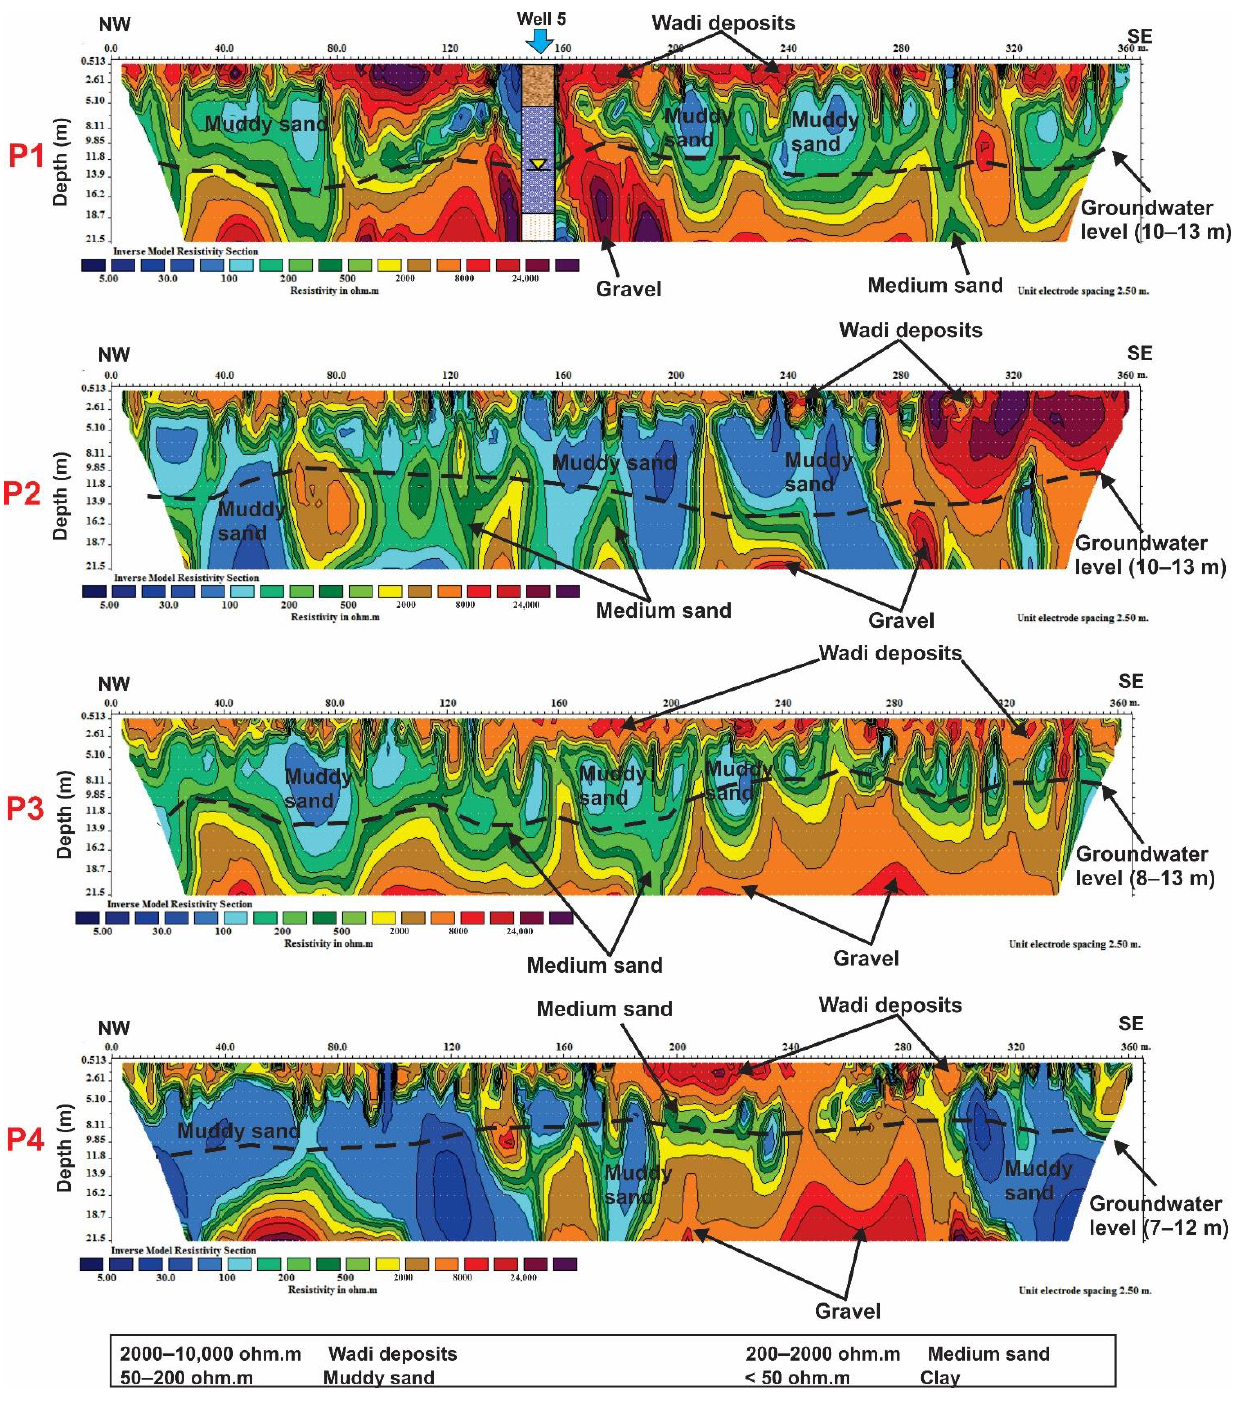
Figure 5. Interpreted 2D inverted resistivity model of profiles 1–4. According to the resistivity values, four difference geoelectric zones were recognized. These zones are: (1) wadi deposits, which are mainly composed of gravels, sands, and silts; (2) medium sand deposits; (3) muddy sand deposits; and (4) clay deposits.